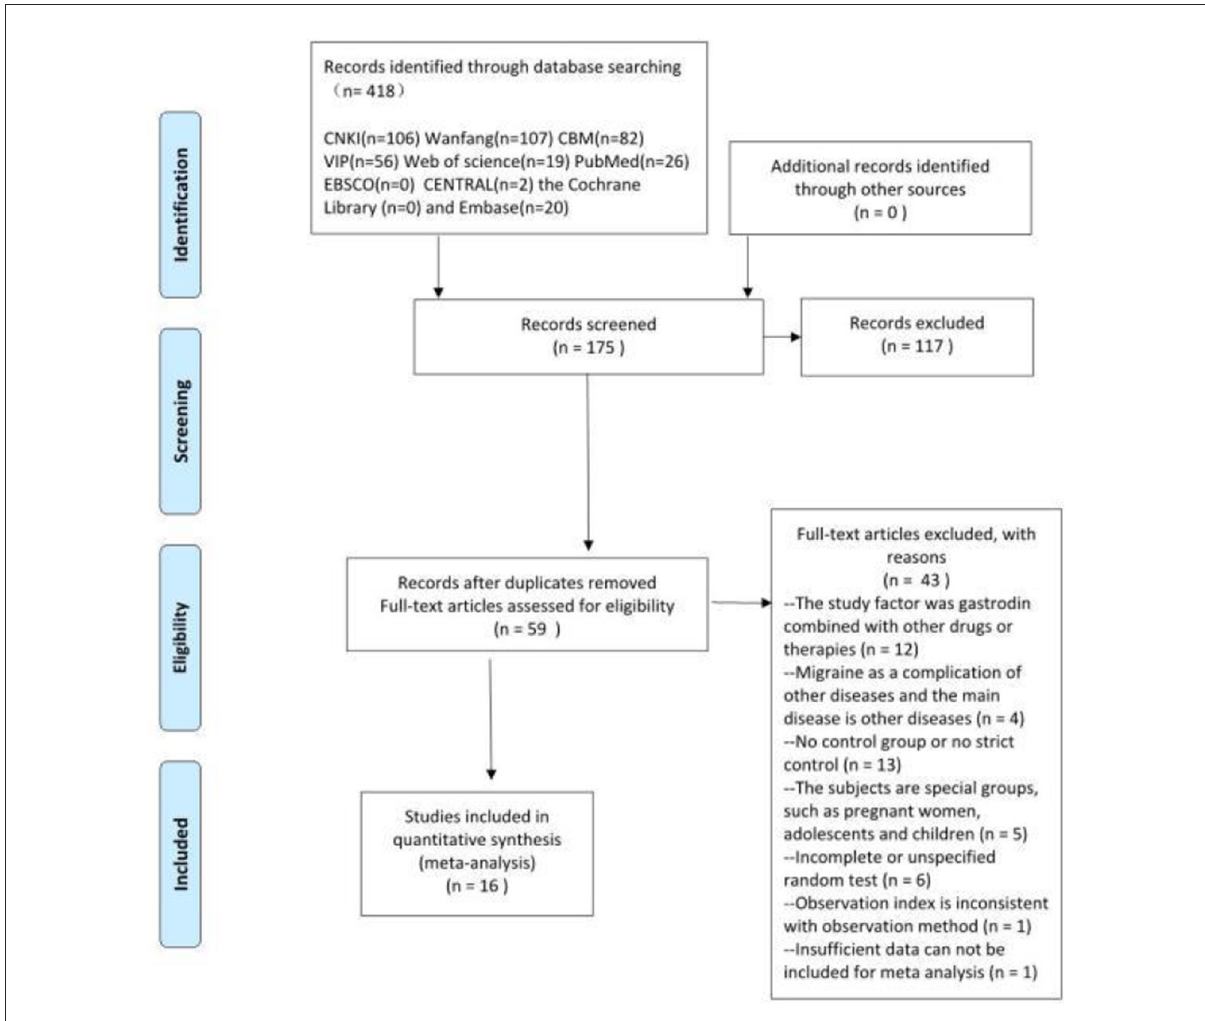
FIGURE1 Flow chart of study selection. From Moher et al.